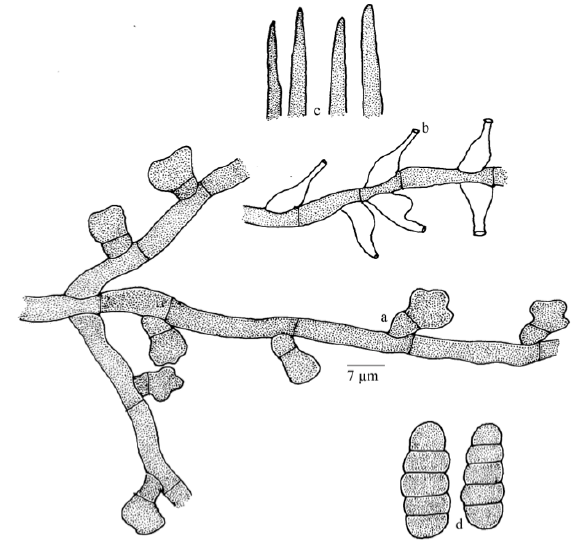
Figure 63 Meliola chandrasekharanii a - Appressorium; b - Phialide; c - Apical portion of mycelial setae; d -